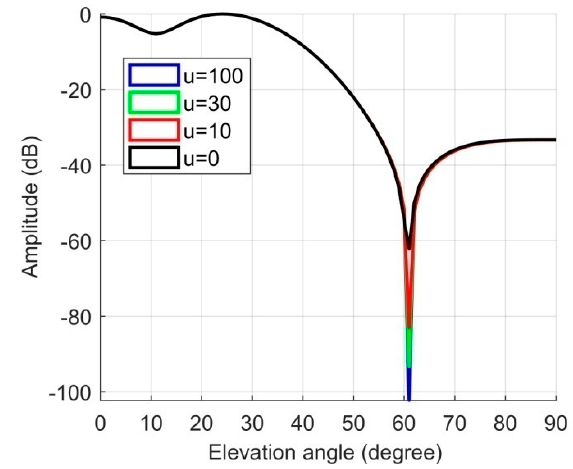
Figure 20. The corresponding nulling for different nulling control coefficients.